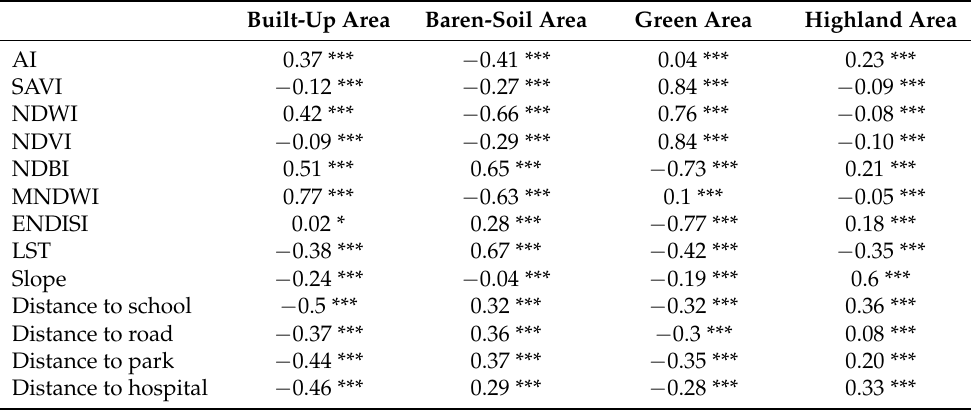
Table 4. Correlation matrix between LULC areas and other environmental variables